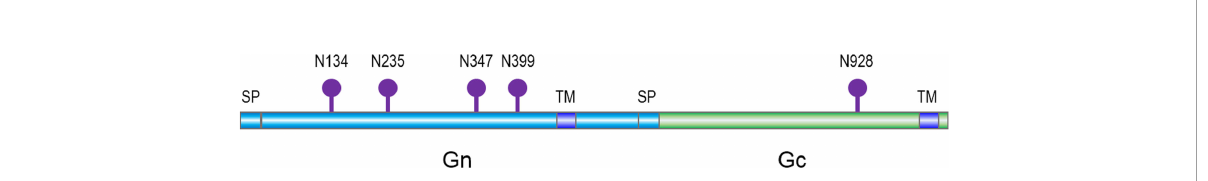
FIGURE 1 A schematic of Hantaan virus (HTNV) glycoprotein and predicted asparagine-linked glycosylation sites (lollipops), with signal peptide (SP) and transmembrane domains